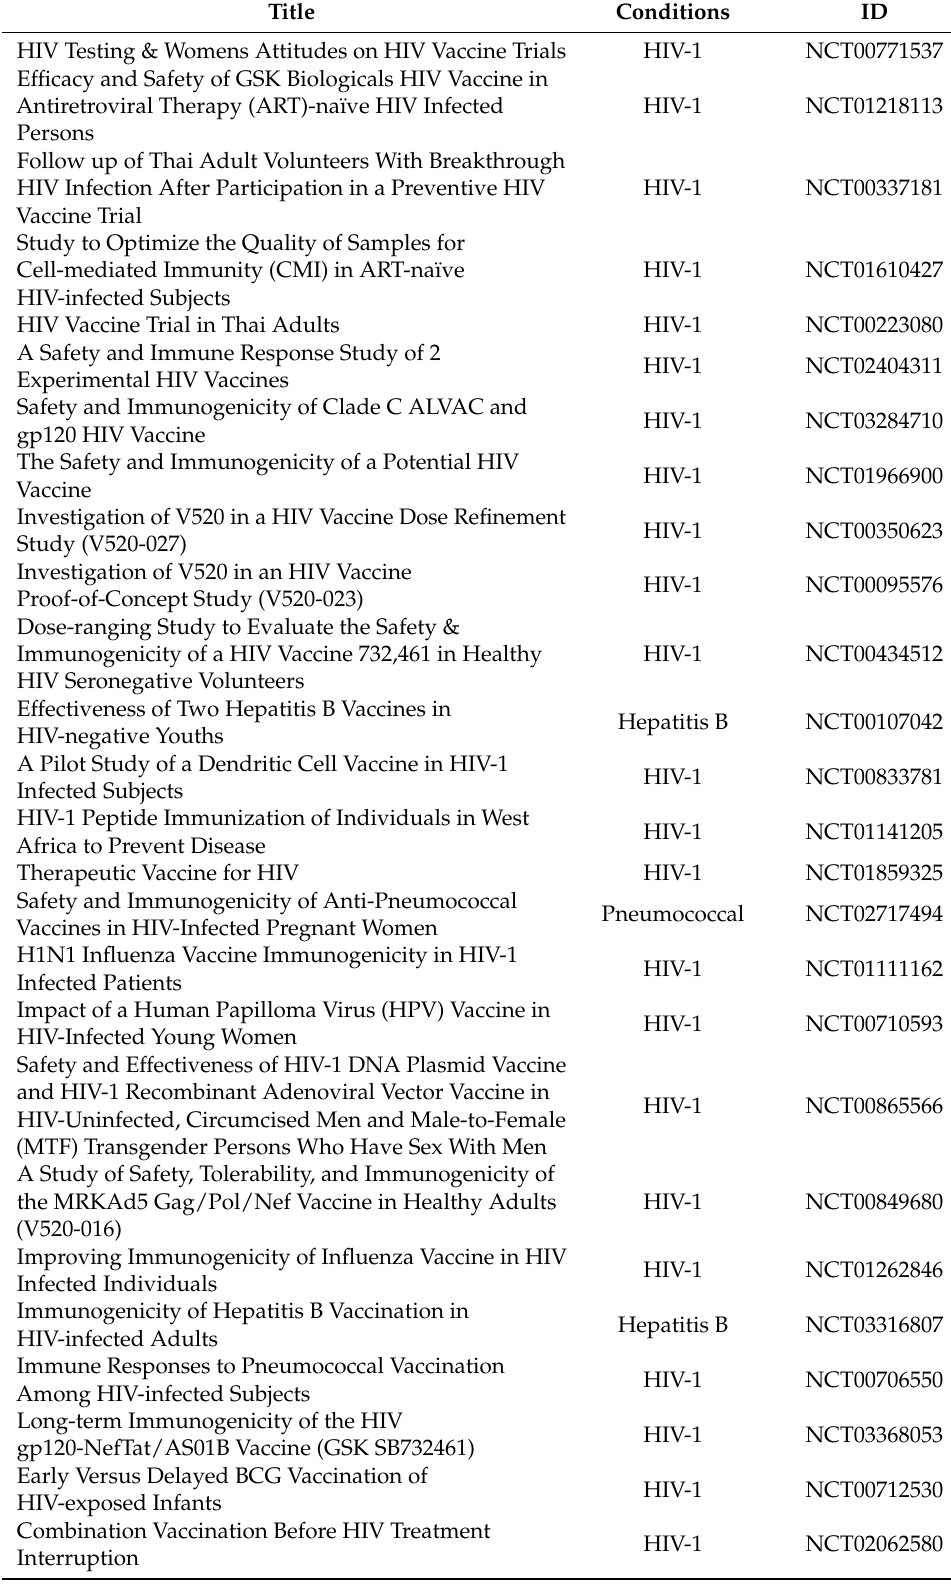
Table 2. Completed HIV-1 vaccine studies according to the clinicaltrials.gov